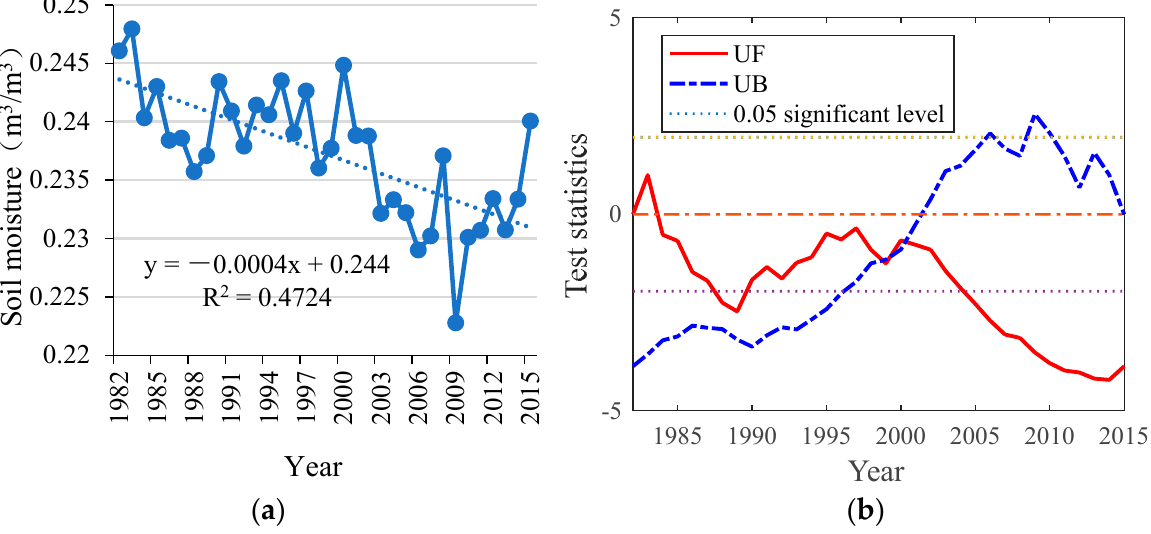
Figure 2. Temporal variation ( a ) and mutation detection ( b ) of the annual mean soil moisture in the karst areas of Southwest China from 1982 to 2015.